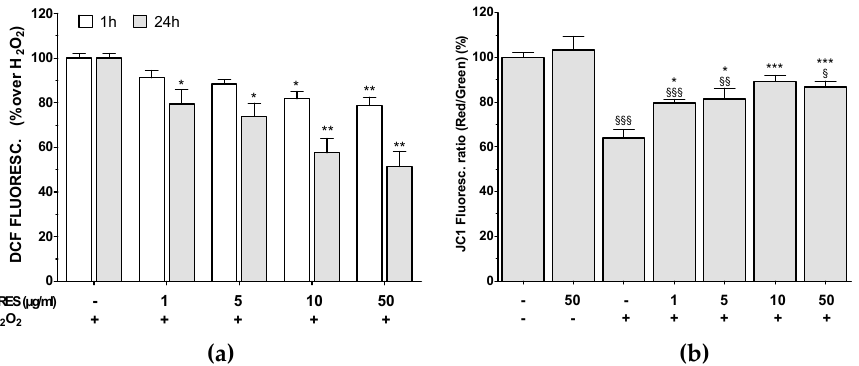
Figure 5. Effects of PRES on OS-induced ROS and ΔΨ m changes in SH-SY5Y cells. ( a ): ROS were evaluated by the oxidation of DCF-DA to DCF ( b ): JC-1 dye was used as a probe for changes of ΔΨ m. The ratio between red/orange- (aggregates, 527 nm) and green- (monomers, 590 nm) emissions was calculated and reported as percent vs. untreated cells. Data are reported as means ± SEMs and analyzed by two-way (DCF) or one-way (JC1) ANOVA. § p < 0.05, §§ p < 0.01, §§§ p < 0.001 vs. untreated cells; * p < 0.05, ** p < 0.01, *** p < 0.001 vs. H 2 O 2 .